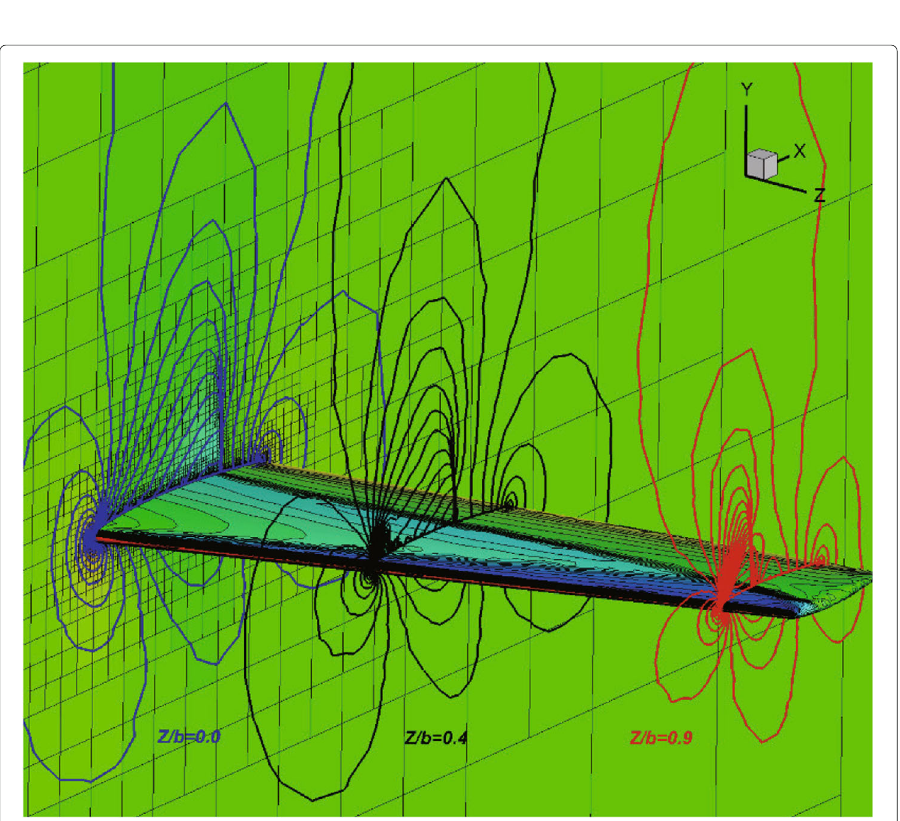
Fig. 23 Pressure contours for flow around ONERA M6 wing ( Z / b = 0, Z / b = 0.4, Z / b = 0.9